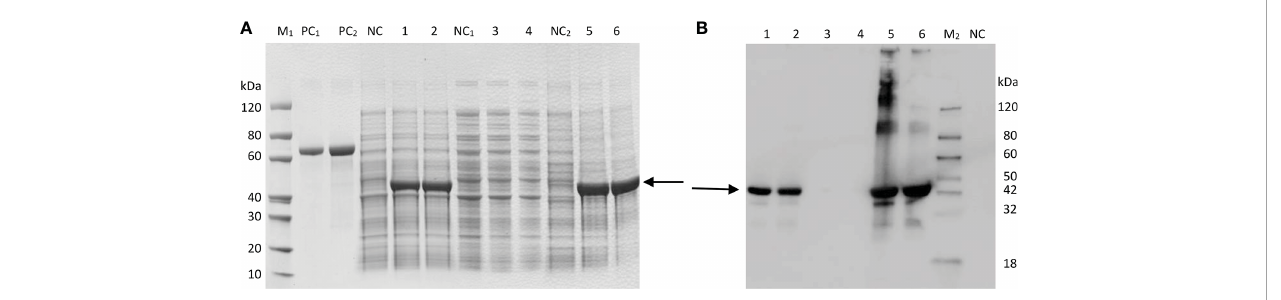
FIGURE 3 Prokaryotic expression analysis of GbFLSa protein. SDS – PAGE. (A) and Western blot (B) analysis of GbFLSa cloned in pET-30a (+) and expressed in the BL21 (DE3) strain. Lane M1: protein marker; Lane M2: western blot marker; Lane PC 1 : BSA (1 m g); Lane PC 2 : BSA (2 m g); and Lane NC: cell lysate without induction. Lane 1: cell lysate with induction for 16 h at 15 °C; Lane 2: cell lysate with induction for 4 h at 37 °C; Lane 3: supernatant of cell lysate with induction for 16 h at 15 °C; Lane 4: supernatant of cell lysate with induction for 4 h at 37 °C; Lane 5: debris of cell lysate with induction for 16 h at 15 °C; and Lane 6: debris of cell lysate with induction for 4 h at 37 °C. The arrowheads indicate induced GbFLSa.